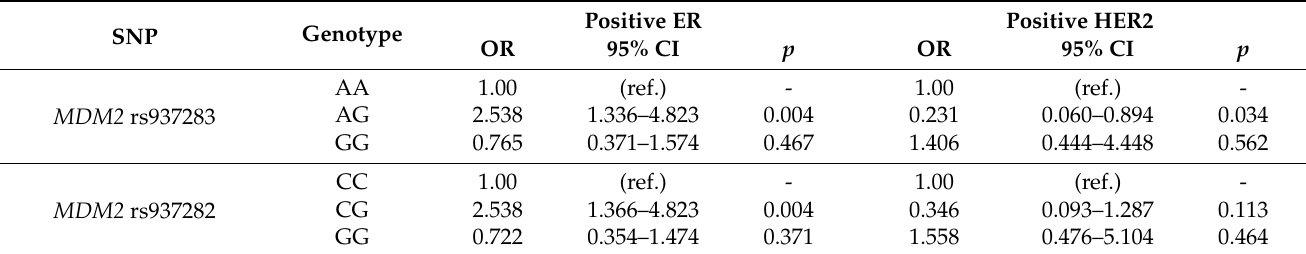
Table 5. Odds ratio for associations of rs937283 A > G and rs937282 C > G with tumor characteristics.